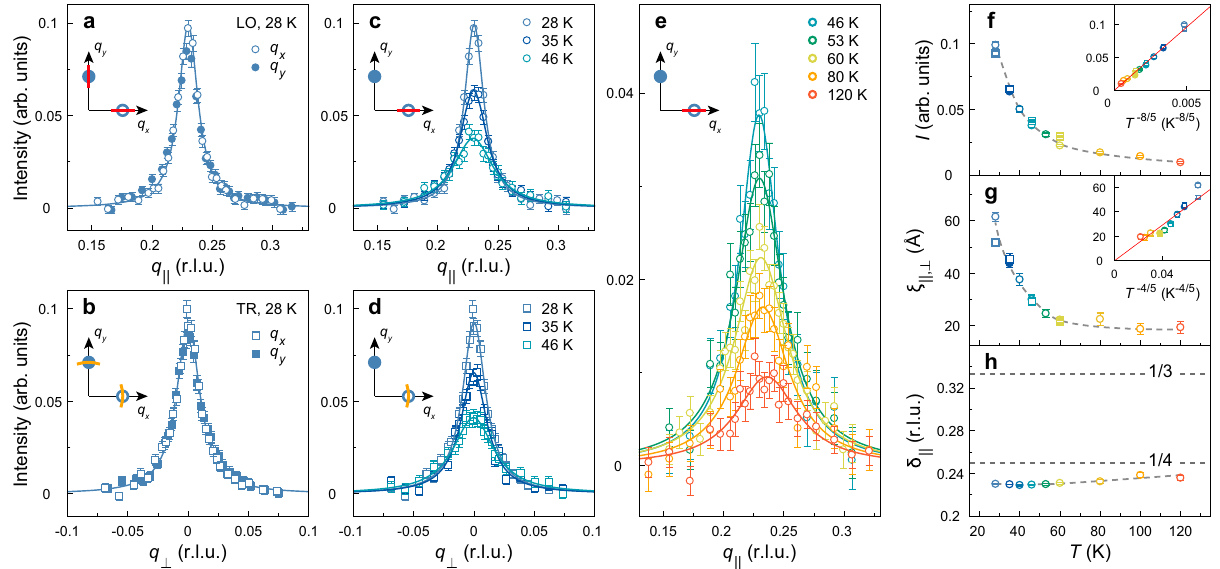
Fig. 3 Temperature evolution of lattice pinned charge-stripe order in La 1.88 Sr 0.12 CuO 4 . a Longitudinal (circles) and b transverse (square) scans through the stripe ordering vectors at T ≈ T c . c – e Temperature dependence of the stripe order diffraction peaks. Solid lines in a – e are Lorentzian fi ts from which amplitude, correlation length and incommensurability are inferred and plotted in f – h versus temperature. Circles and squares in f – h denote fi tting results from the longitudinal and transverse scans, respectively. Error bars in a – e and f – h are set by counting statistics and standard deviation of fi ttings, respectively. Dashed lines in f , g are guides to the eyes. The two horizontal dashed lines in h indicate lattice commensurate values. Red solid lines in the insets of f , g are linear fi